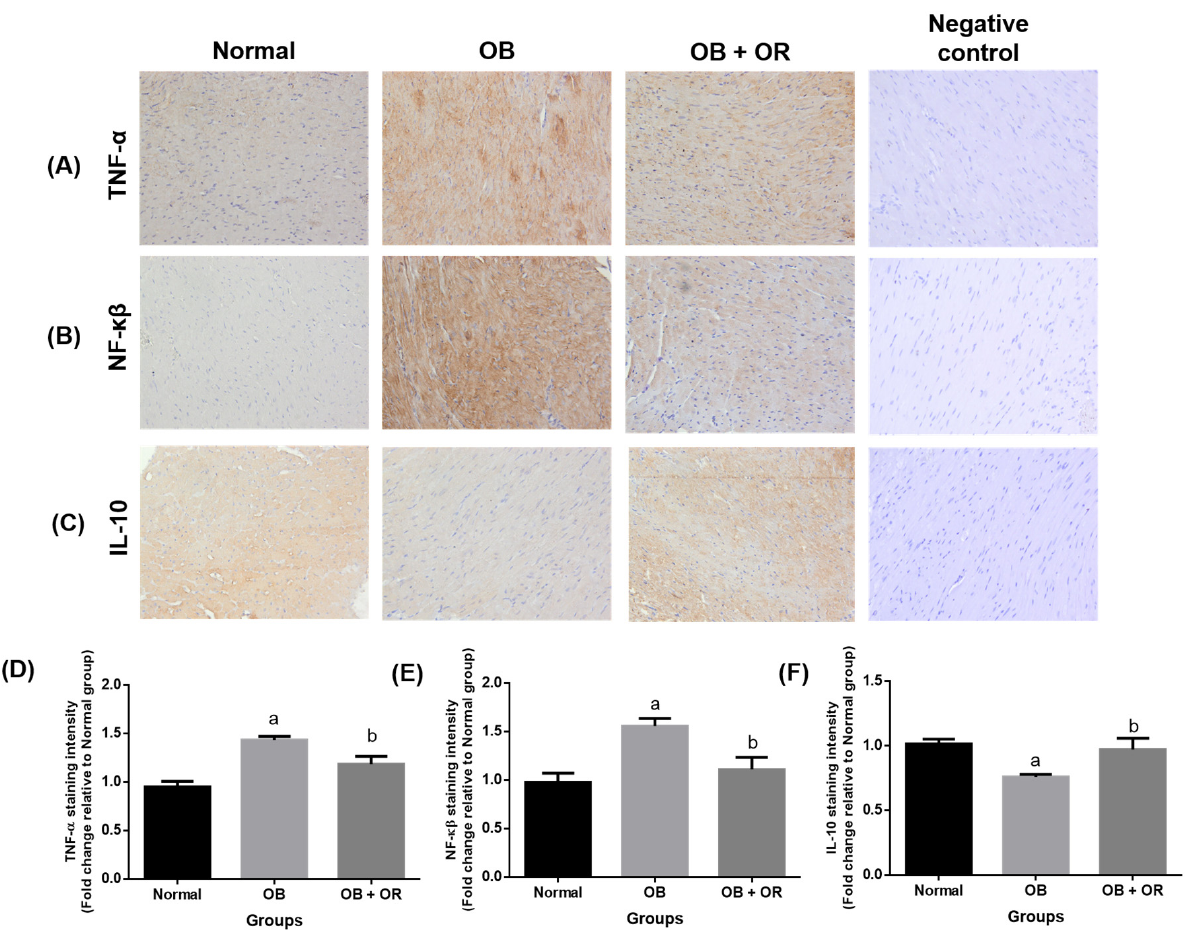
Figure 3. Effects of orlistat on immunoexpressions of ( A ) TNF- α , ( B ) NF-k β , and ( C ) IL-10 in cardiac section of rats in Normal, OB (obese control), OB + OR (obese and orlistat 10 mg/kg/day) and negative control groups (magnification = × 400, scale bar = 50 µ m). For each target protein, phosphate buffered saline was substituted for the primary antibody in the negative control experiment. Staining intensities are shown in ( D – F ) and presented as mean and S.E.M values for respective proteins; n = 6 rats per group. a p < 0.05 compared with Normal group, b p < 0.05 compared with OB group. Data were analyzed by One-way ANOVA followed by Tukey’s post-hoc